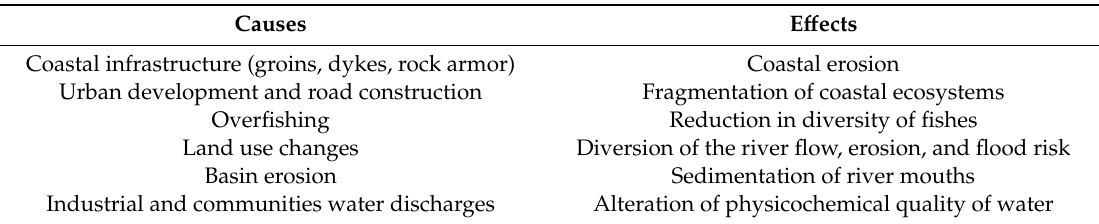
Table 3. Causes and e ff ects of anthropic activities in CGSM.